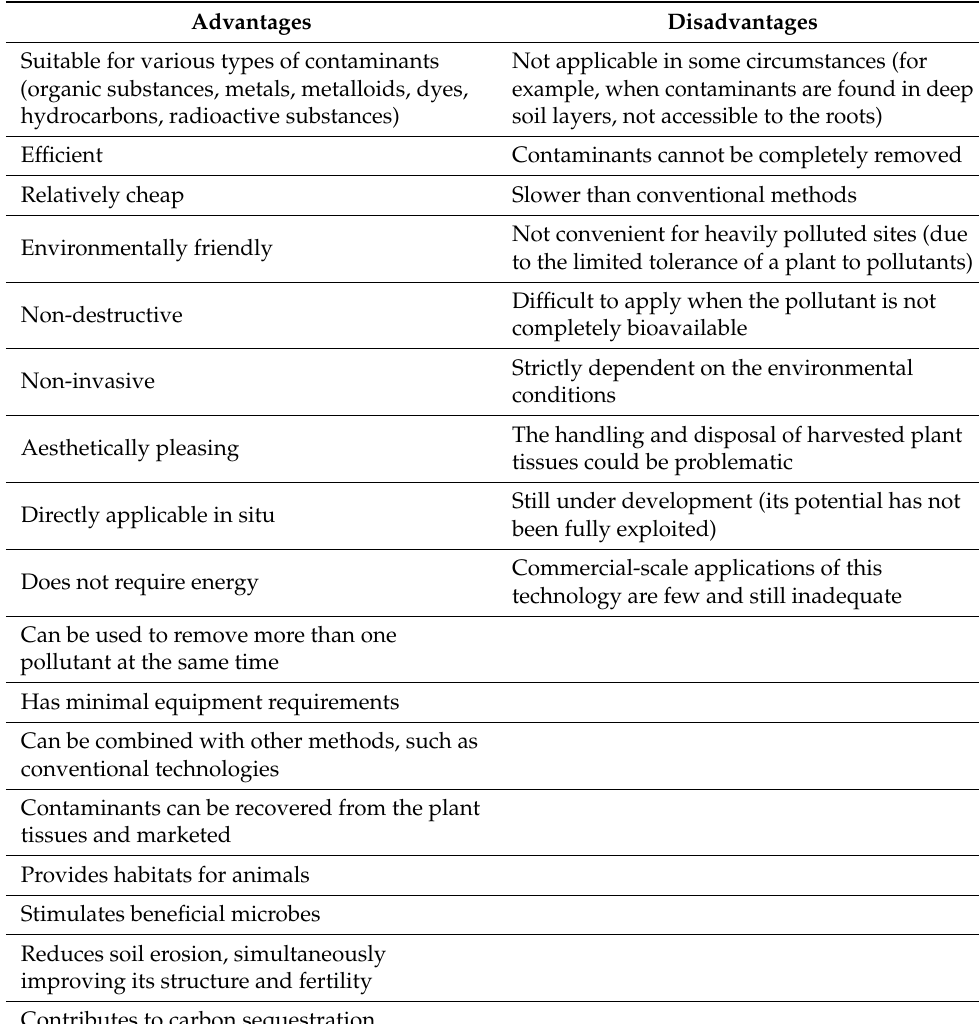
Table 1. Advantages and disadvantages of